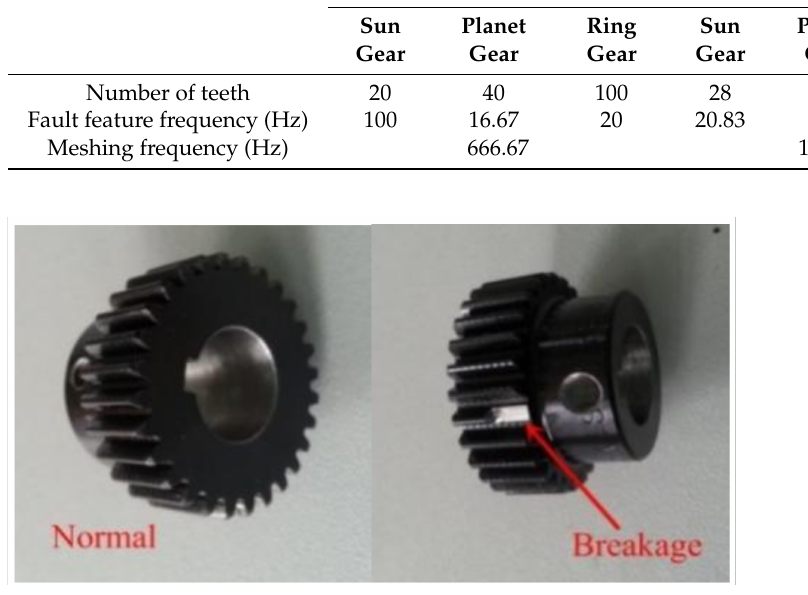
Figure 12. The measured sun gears.